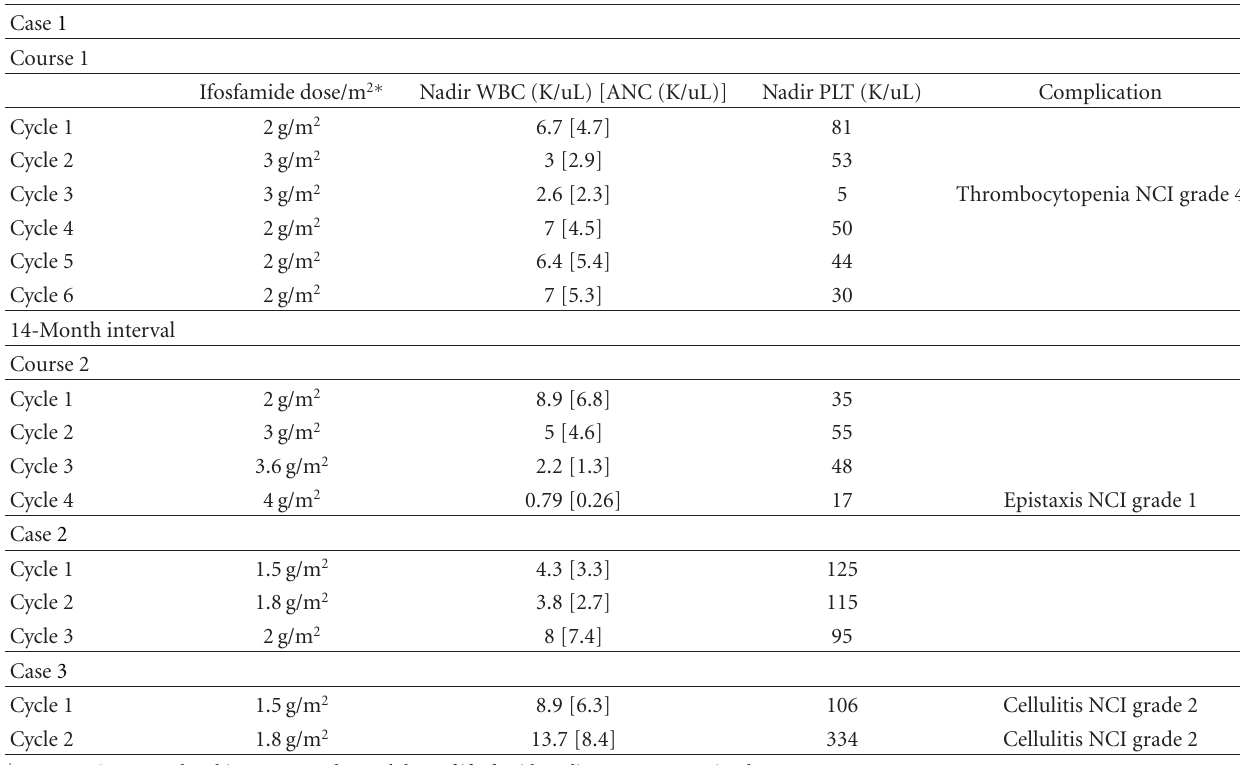
Table 1: Dosing schedule, nadir counts and reported complications in Cases 1, 2 and